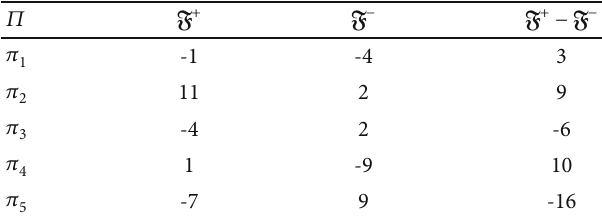
Table 21: The fi nal score